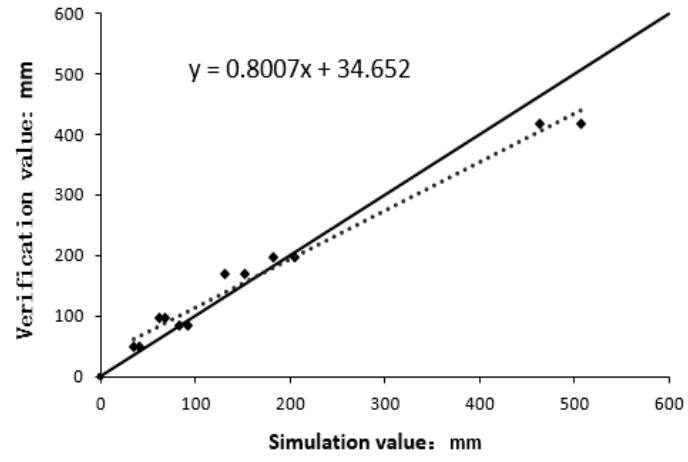
Figure 6. Degree of similarity between the simulation value and verification value.